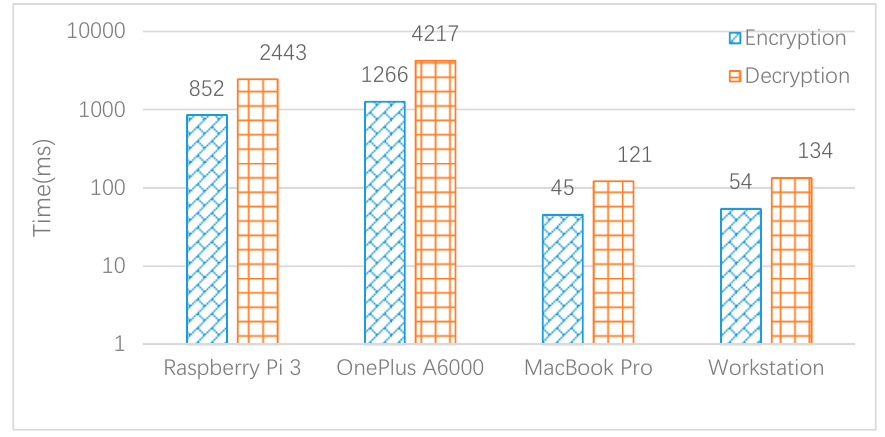
Figure 5. Data encapsulation mechanism’s (DEM’s) encryption and decryption performance (using the stream cipher).